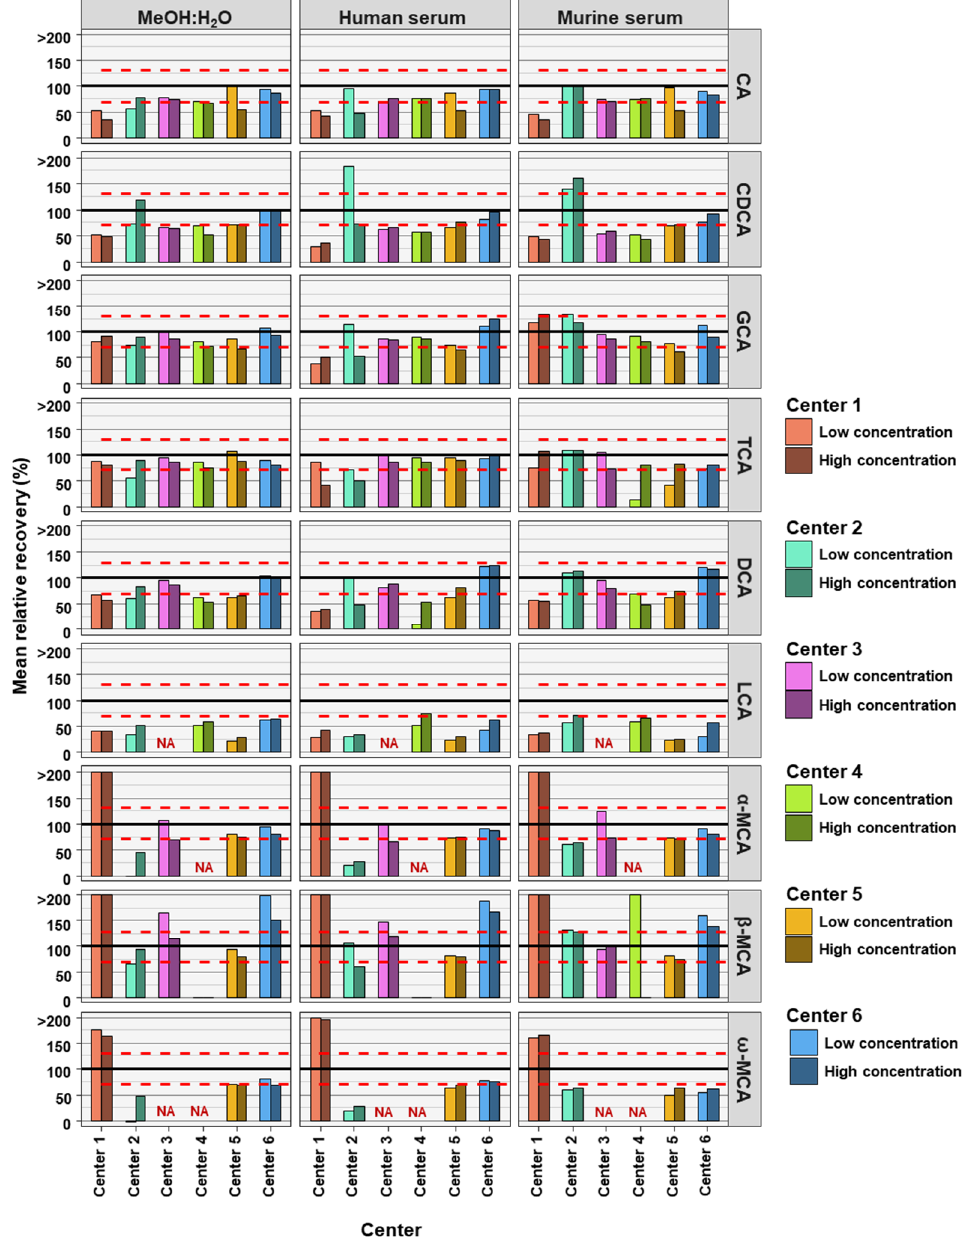
Figure 2. Accuracy of bile acid analyses of each assessing center. Mean relative recovery (n = 6) of the nine bile acids spiked into the MeOH:H 2 O solvent, as well as human and murine serum, at high and low concentration levels. The red dashed line represents relative recovery values of 70% (lower line) and 130% (higher line). NA = not applicable, those BAs are not covered by the specific center.